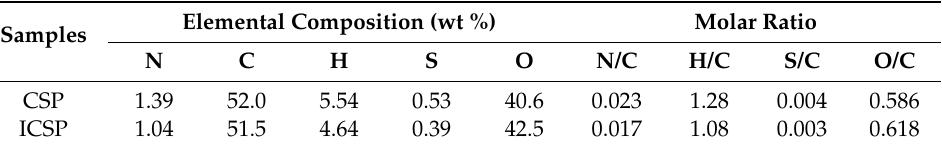
Table 2. Elemental compositions and molar ratios of CSP and